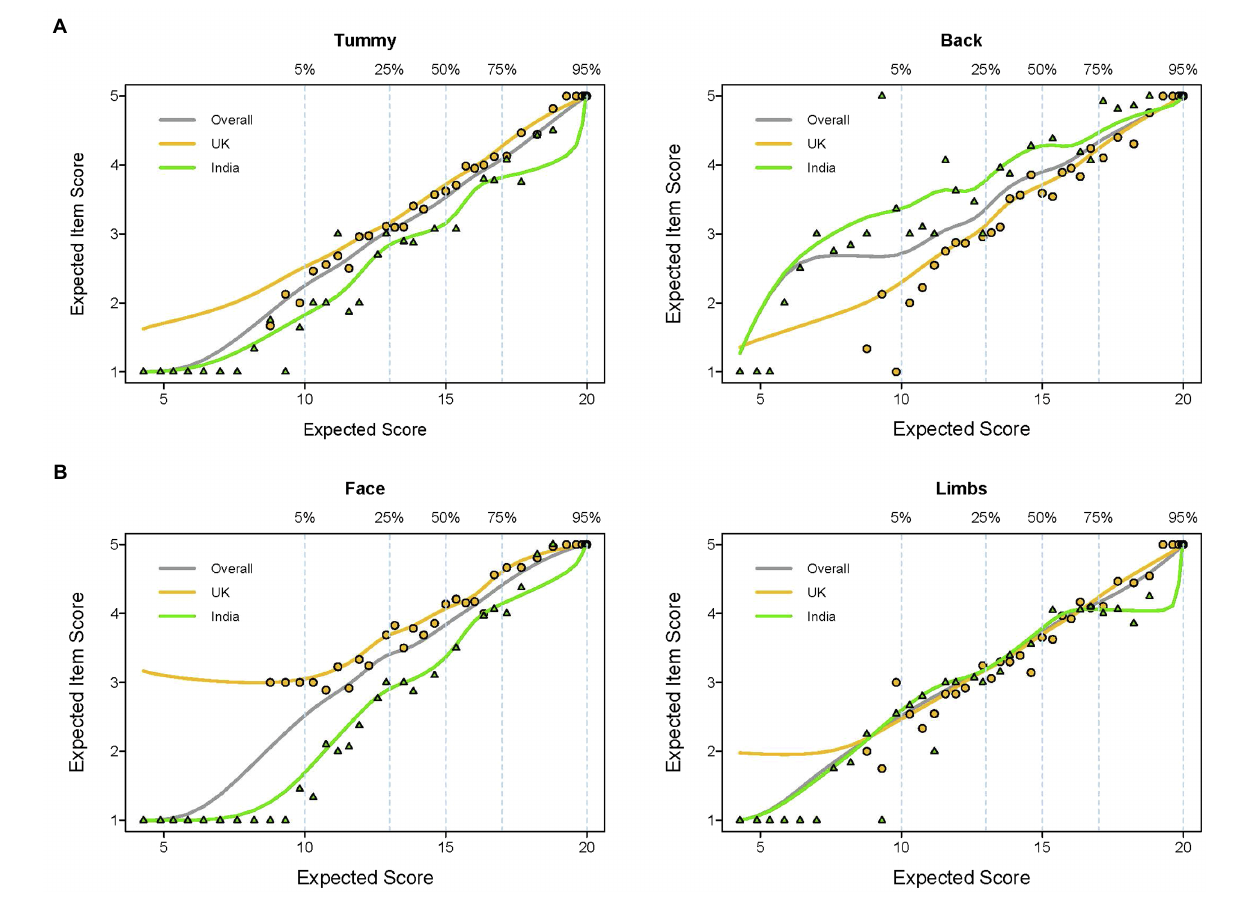
FIGURE 2 | Comparison of Item-Response Functions (IRF) for the four stroking items for India versus United Kingdom mothers. Expected item scores are presented as a function of expected total scores illustrating two issues: (A) monotonicity (the likelihood of items being endorsed with increases in the latent propensity of stroking behavior) and (B) whether the latent propensity to stroke shows the same pattern of item response in the different countries. The percentage scale indicates the cumulative proportion of the sample that have the corresponding total scores and the points represent groups of participants (grouped by ordinal ability). The IRFs are compared in each country, with Indian IRFs in green and the United Kingdom in